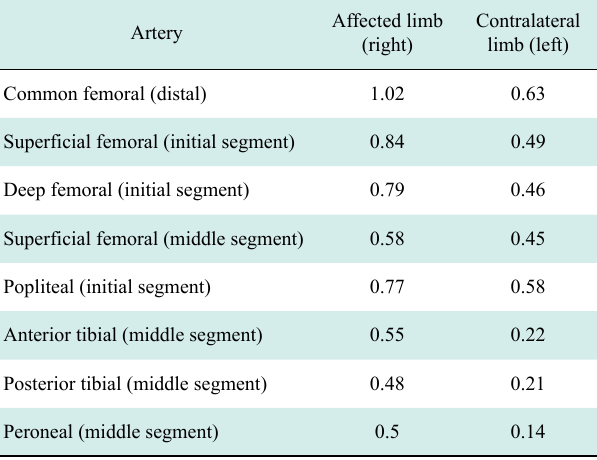
Table 1 Internal diameters of arteries in the lower limbs (cm)